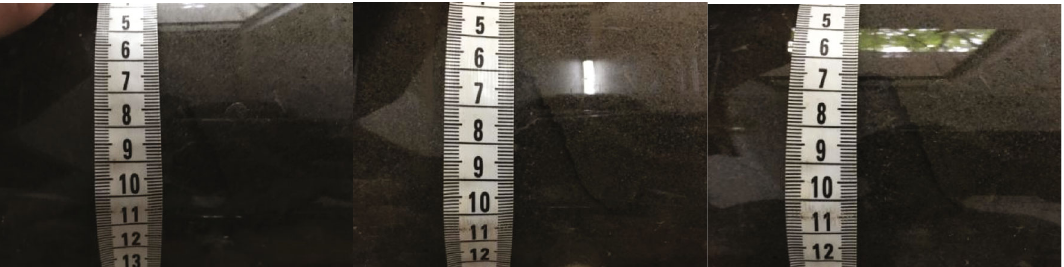
Figure 9: Diagram of crack